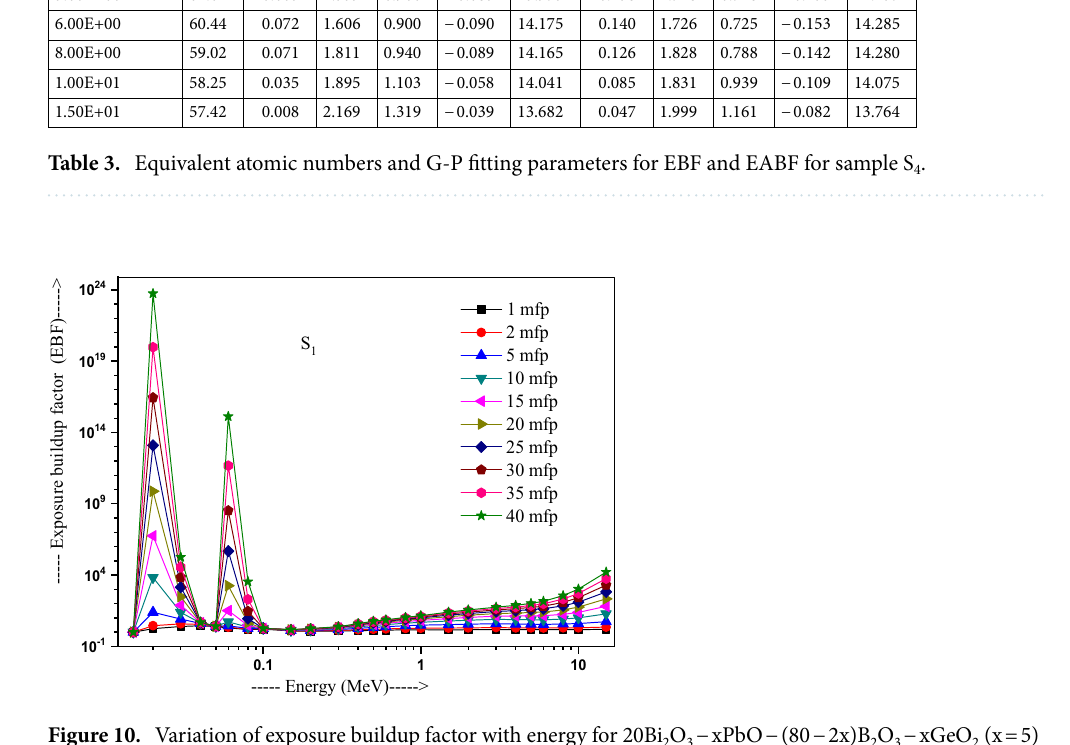
Figure 10. Variation of exposure buildup factor with energy for 20Bi 2 O 3 − xPbO − (80 − 2x)B 2 O 3 − xGeO 2 (x = 5) glass (S 1